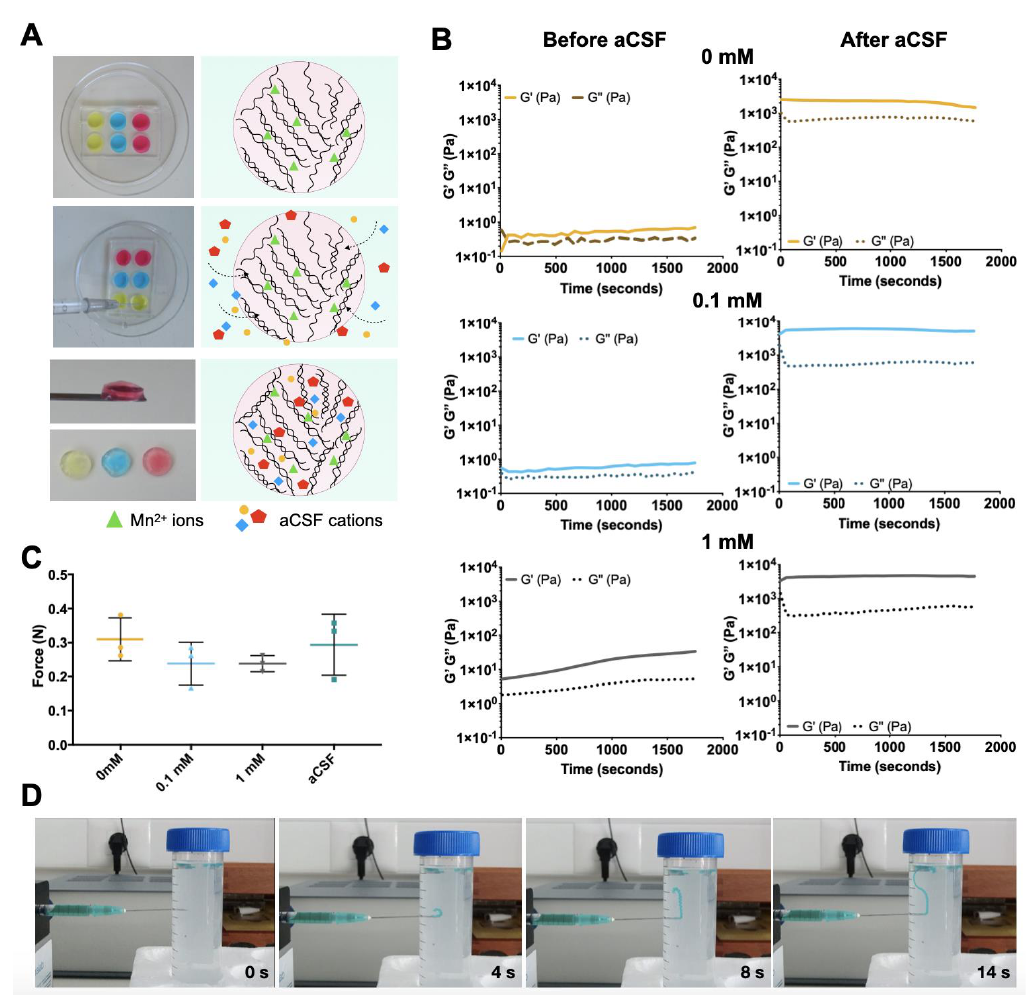
Figure 1. Preparation and rheological characterization of the Mn-based methacrylated gellan gum (GG-MA) hydrogels. ( A )—Schematic representation of Mn-based GG-MA hydrogel preparation. Pre-gel solutions are poured into silicon templates, followed by the addition of aCSF, resulting in cylindrical hydrogels; ( B )—oscillatory time sweeps (30 min) of the different hydrogel formulations, before and after addition of aCSF; ( C ) injection force registered after 30 s of hydrogel injection into tube filled with aCSF. Average ± SD, n = 3. ( D ) Time-lapse of hydrogel injection into aCSF. Injection was performed with an 18G needle and with colored hydrogel for better visualization.